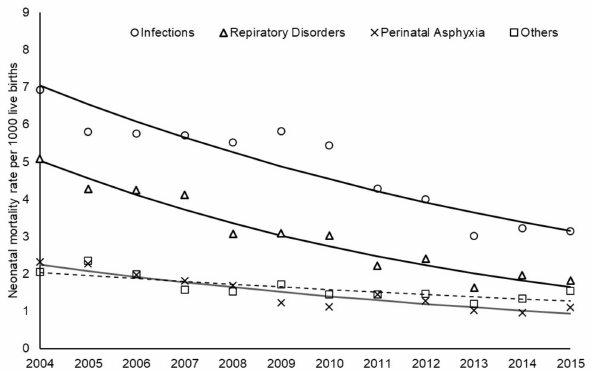
Figure 3. Annual trend of neonatal mortality rate of infants with 32 0/7 –36 6/7 weeks gestation without congenital malformations adjusted by Prais–Winsten model, according to cause of death (o, ∆ , (cid:3) and × observed rate; −−− or - - - expected